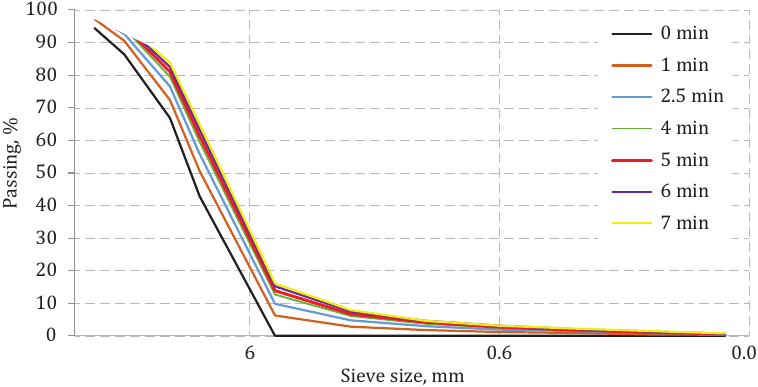
Figure 4. Gradation of RAP aggregates after each step of processing